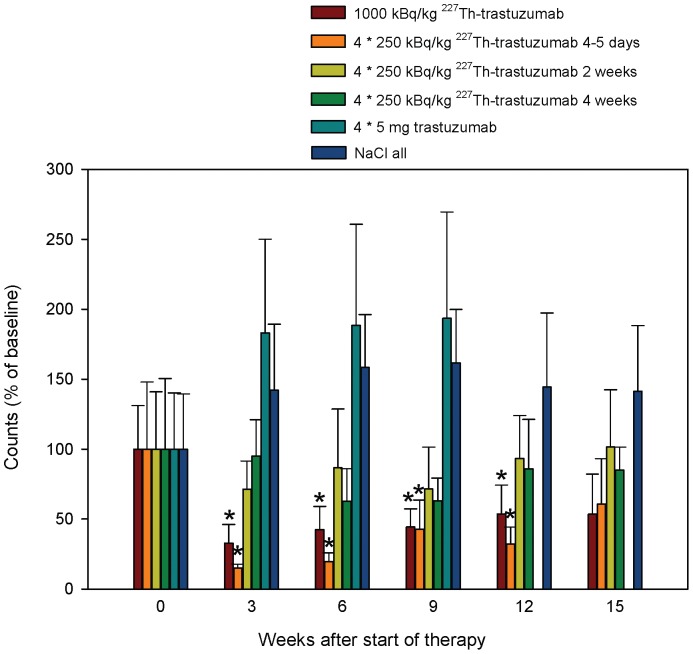
White blood cell counts as function of time.Normalized, pooled white blood cell counts for mice carrying SKOV-3 and SKBR-3 tumor xenografts as function of weeks after onset of therapy. In animals given saline (NaCl) data from animals without tumor are pooled with data from tumor-carrying animals. Whole blood from vena saphena lateralis was collected in EDTA-coated tubes and analyzed using an automated hematology analyzer (Scil Vet abc animal blood counter). Error bars are standard deviation. Results statistically significantly lower than baseline value are marked by an asterisk.